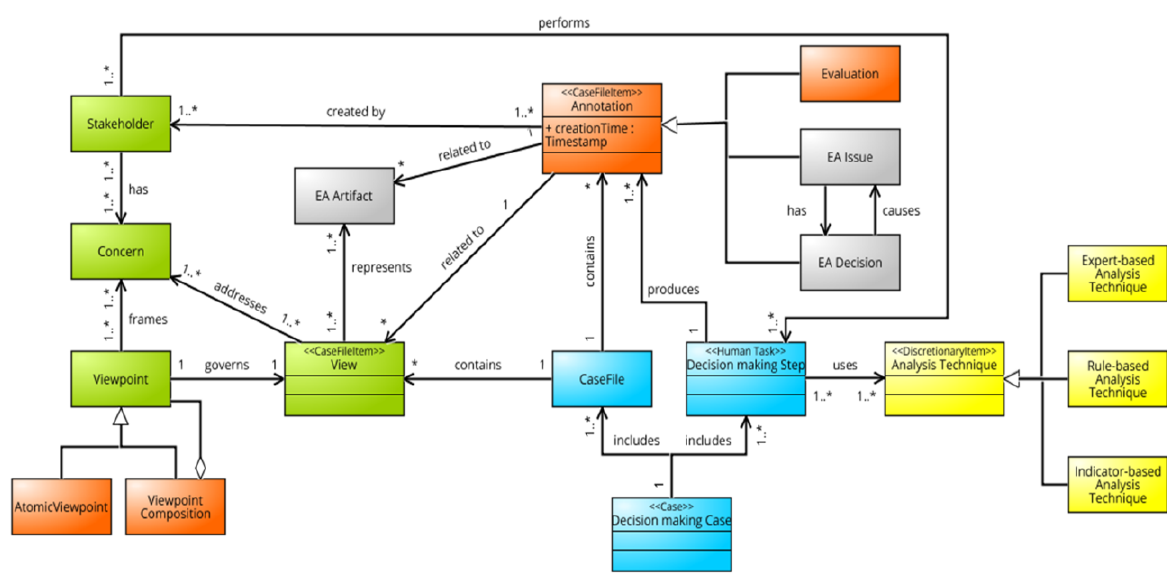
Figure 5. Collaborative EA Decision Making